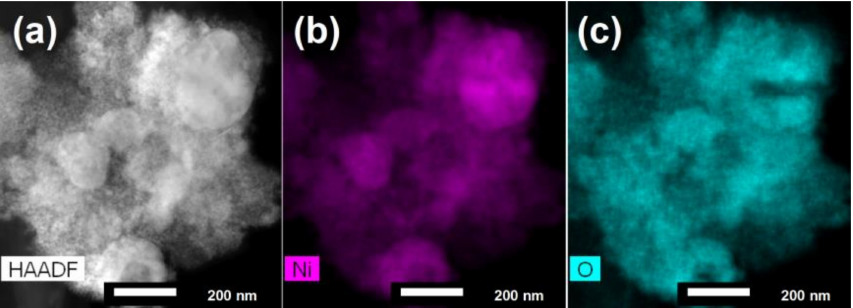
Figure 7. ( a ) HAADF image, and ( b , c ) STEM-EDX mapping results for Ni and O elements of particles obtained with pulsed laser irradiation with irradiation time 10 min.